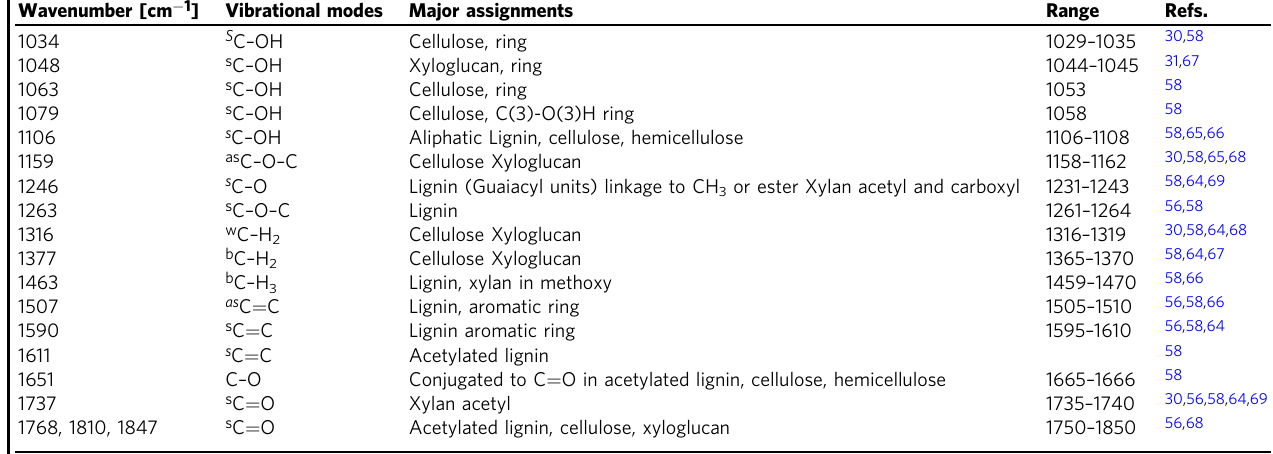
Table 1 Main vibrational modes